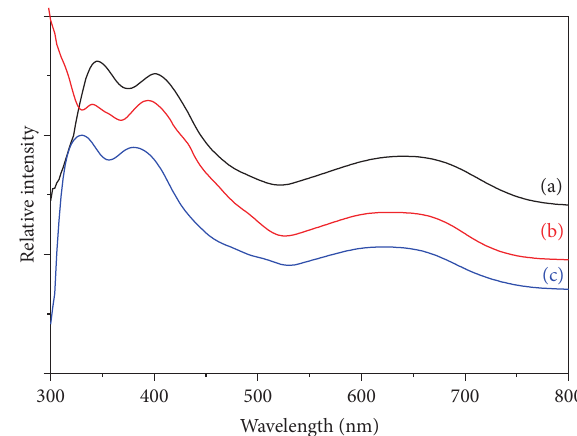
Figure 1: FTIR spectra of (a) Chitosan, (b) CGPNMA, (c) CGP2MA, and (d)